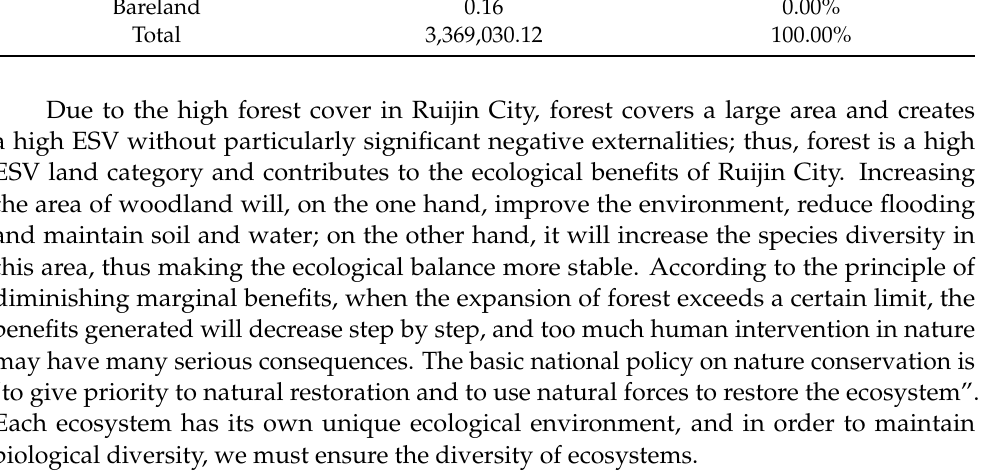
Table 5. Ecosystem service values by land use type in Ruijin City in 2020 (unit: ten thousand Yuan). Land Use Type ESV Percentage Cultivated land 92,764.95 2.75% Forest 2,993,497.87 88.85% Grassland 547.63 0.02% Water 282,219.51 8.38% Bareland 0.16 0.00% Total 3,369,030.12 100.00%